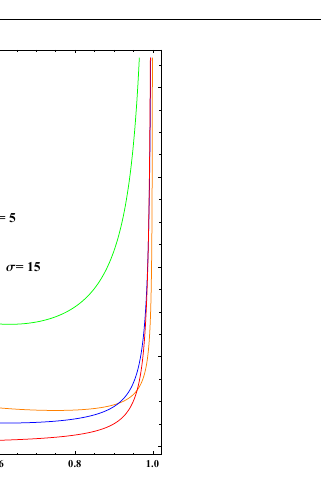
Figure 2 –: Hazard quantile function for different choices of